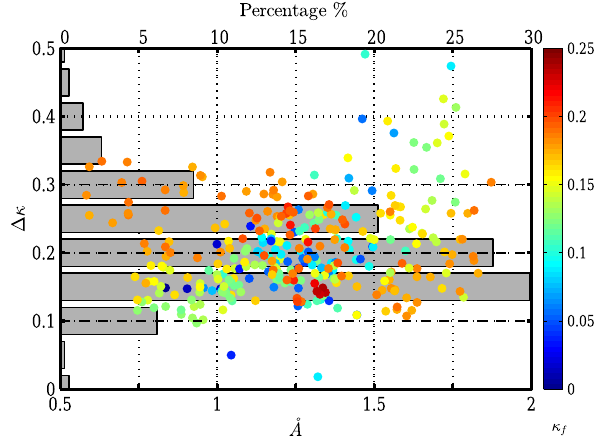
Figure 6. Differences between κ c and κ f , referred to as (cid:49)κ , with Å (positions of dots) and κ f (colors of dots). Bars represent percent- ages of (cid:49)κ within different